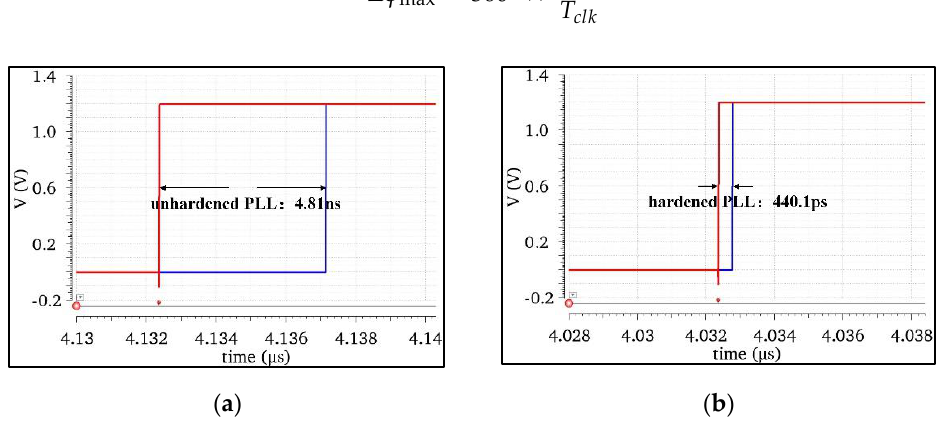
Figure 12. Simulation results of the maximum phase displacement before and after hardening: ( a ) maximum phase shift before hardening; ( b ) maximum phase shift after hardening. Table 1. Performance comparison of the PLL before and after hardening.